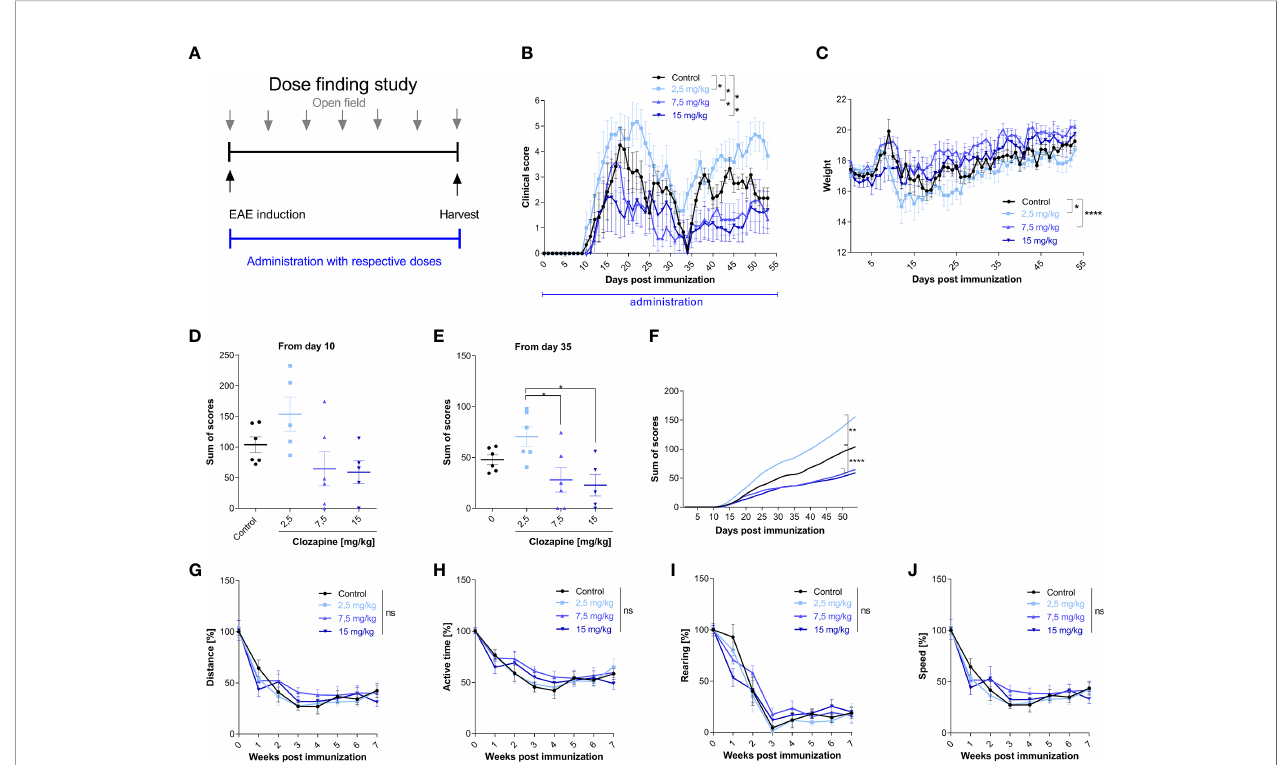
FIGURE 2 | Treatment with clozapine ameliorates chronic EAE dose-dependently in a prophylactic treatment paradigm. (A) MOG-immunized C57BL6/J mice (female, 8 weeks old) were treated with different clozapine concentrations (2.5 mg/kg, 7.5 mg/kg, 15 mg/kg) or 5% DMSO/0.0025% acetic acid in saline (control) once a day from day 0 and evaluated weekly using the open fi eld analysis. (B) The clinical scores and (C) weight of mice treated with 2.5 mg/kg clozapine declined (p = 0.0228 for score, p = 0.0357 for weight) whereas the groups treated with 7.5 mg/kg (p=0.0059 for score, p = < 0.0001 for weight) and 15 mg/kg clozapine (p = 0.0016 for score) improved compared to the control group. (D) Differences in sum of scores were not signi fi cant regarding the timespan of clinical signs from day 10. (E) Sum of scores during the chronic phase of EAE (from day 35) differed signi fi cantly for 7.5 mg/kg (p = 0.0222) and 15 mg/kg (p = 0.0136) treated groups compared to the 2.5 mg/kg treated group. (G – J) Open fi eld experiments were conducted to measure the sedative effect of clozapine. Groups did not differ regarding distance, active time, rearing and speed. Control group, 2.5 mg/kg group and 7.5 mg/kg group n=6, 15 mg/kg group n=5. Data are shown as mean ± SEM. Non-parametric Kruskal-Wallis test (B – E, G – J) and ordinary one-way ANOVA (F) with 95% con fi dence interval. Signi fi cances are depicted as *p < 0.05, **p < 0.01, ****p < 0.001, ns: not signi fi cant